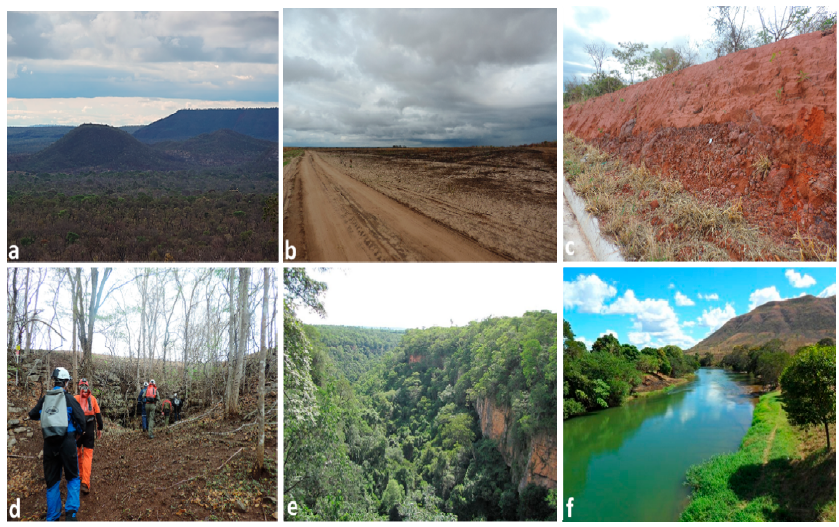
Figure 3. Pictures of the study area ( a ) the escarpment; ( b ) the very flat upper part of the sandstone; ( c ) the formation of oxisoil; ( d ) dolines opened in convex-concave hill-slopes covered by claystone; ( e ) canyons compartment formed as a result of cave collapse; and ( f ) the lower base level, connected with the base level.